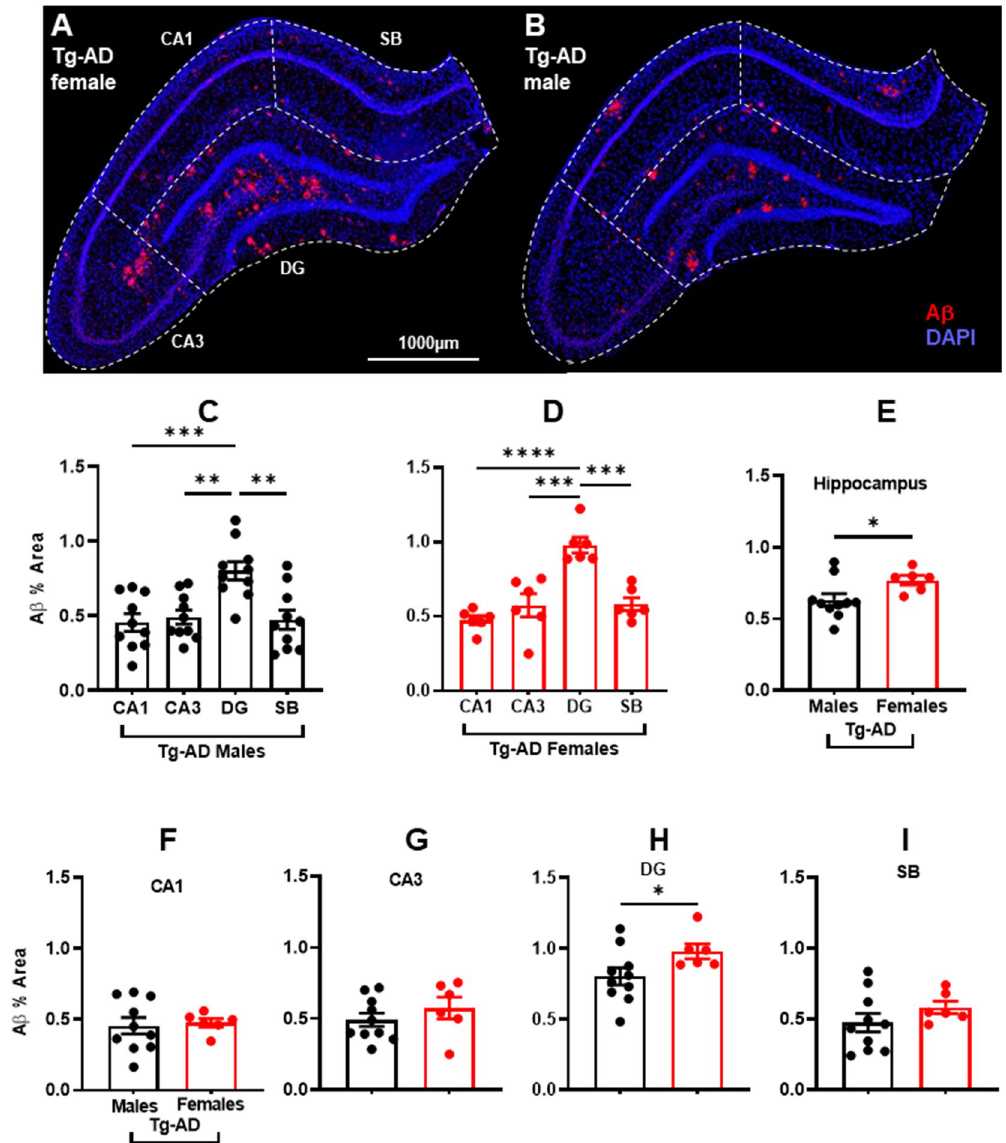
Figure 2. Aβ plaque burden is significantly higher in transgenic females than in males in total hippocampus and dentate gyrus (DG). Representative Aβ (red) and DAPI (blue) staining images for a transgenic female ( A ) and a transgenic male rat ( B ). Scale bar, 1000 µm. Hippocampal region perimeters are depicted in each image by white dashed lines. Plaque burden in transgenic males ( C ) and females ( D ) was significantly higher (~ 1.7-fold) in DG than in other hippocampal regions. Significant increased plaque burden (*P < 0.05) was observed in TG females in whole hippocampus ( E ) and DG ( H ). No difference in plaque burden was observed in CA1, CA3, and SB ( F , G , I ). Ordinary one-way ANOVA with Tukey’s post-hoc analysis was used in Fig. 1C,D. Unpaired two- tail t-tests with Welch’s corrections were used in 1E through 1I. *P < 0.05. Tg-AD males (n = 10), Tg-AD females (n = 6). CA Cornu Ammonis, DG Dentate Gyrus, SB